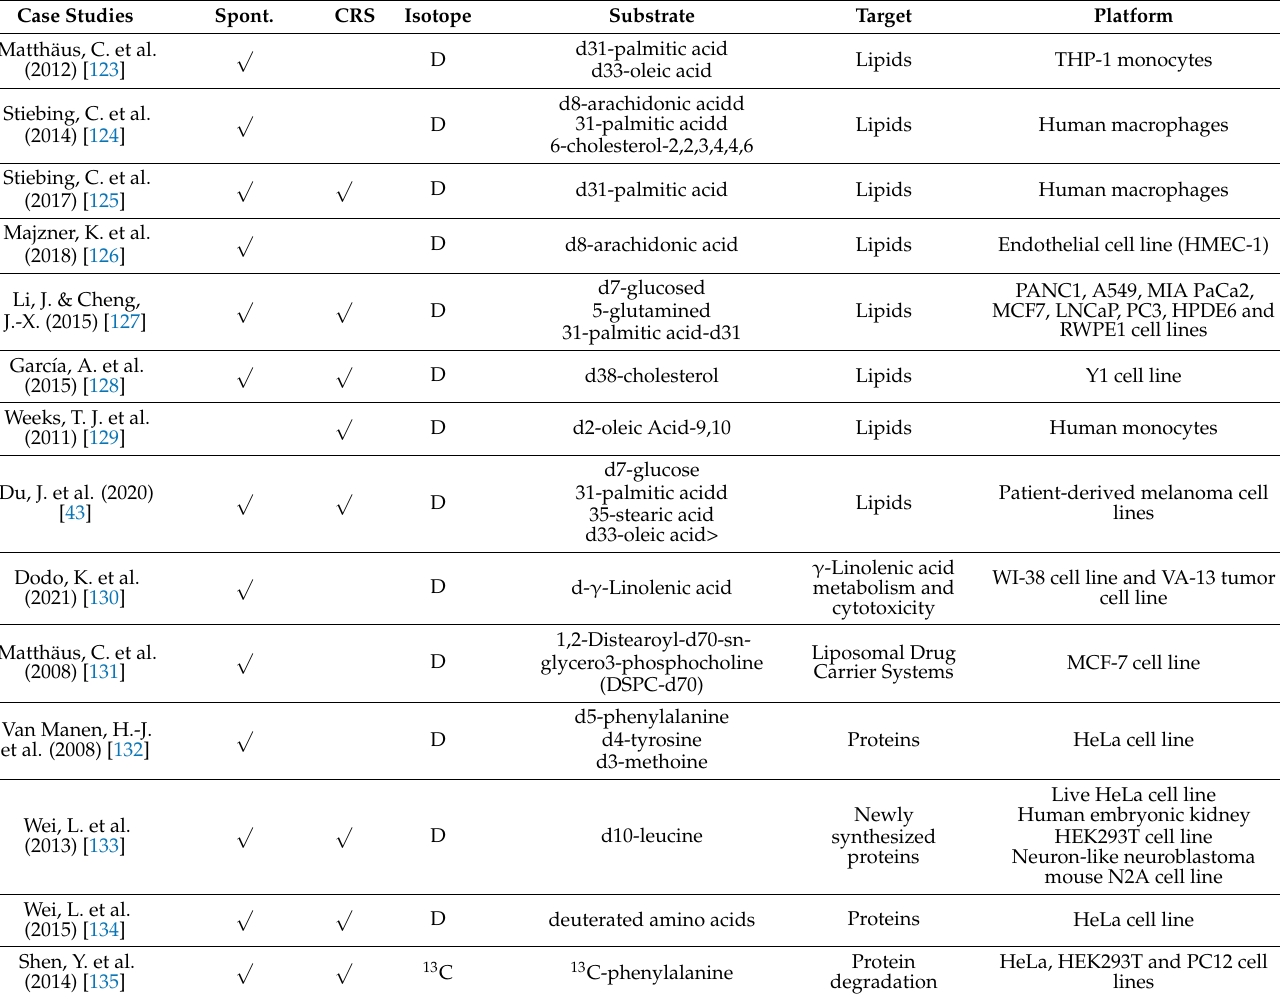
Table 2. Studies using Raman–SIP to probe metabolism in mammalian cells. “Spont.” refers to spontaneous Raman. Case Studies Spont. CRS Isotope Substrate Target